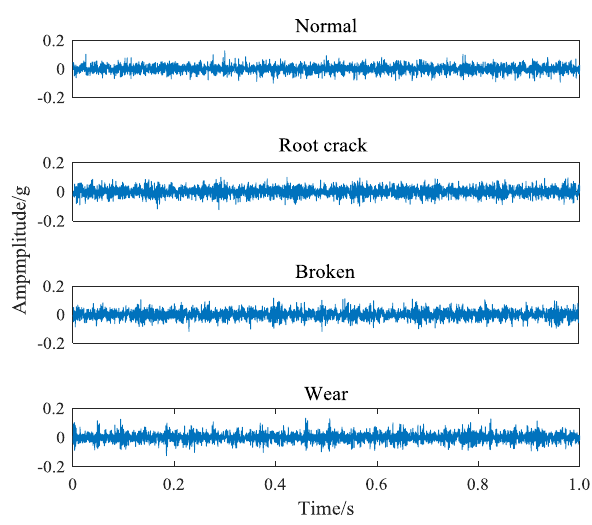
Figure 4. Time-domain signals of four different gear states.